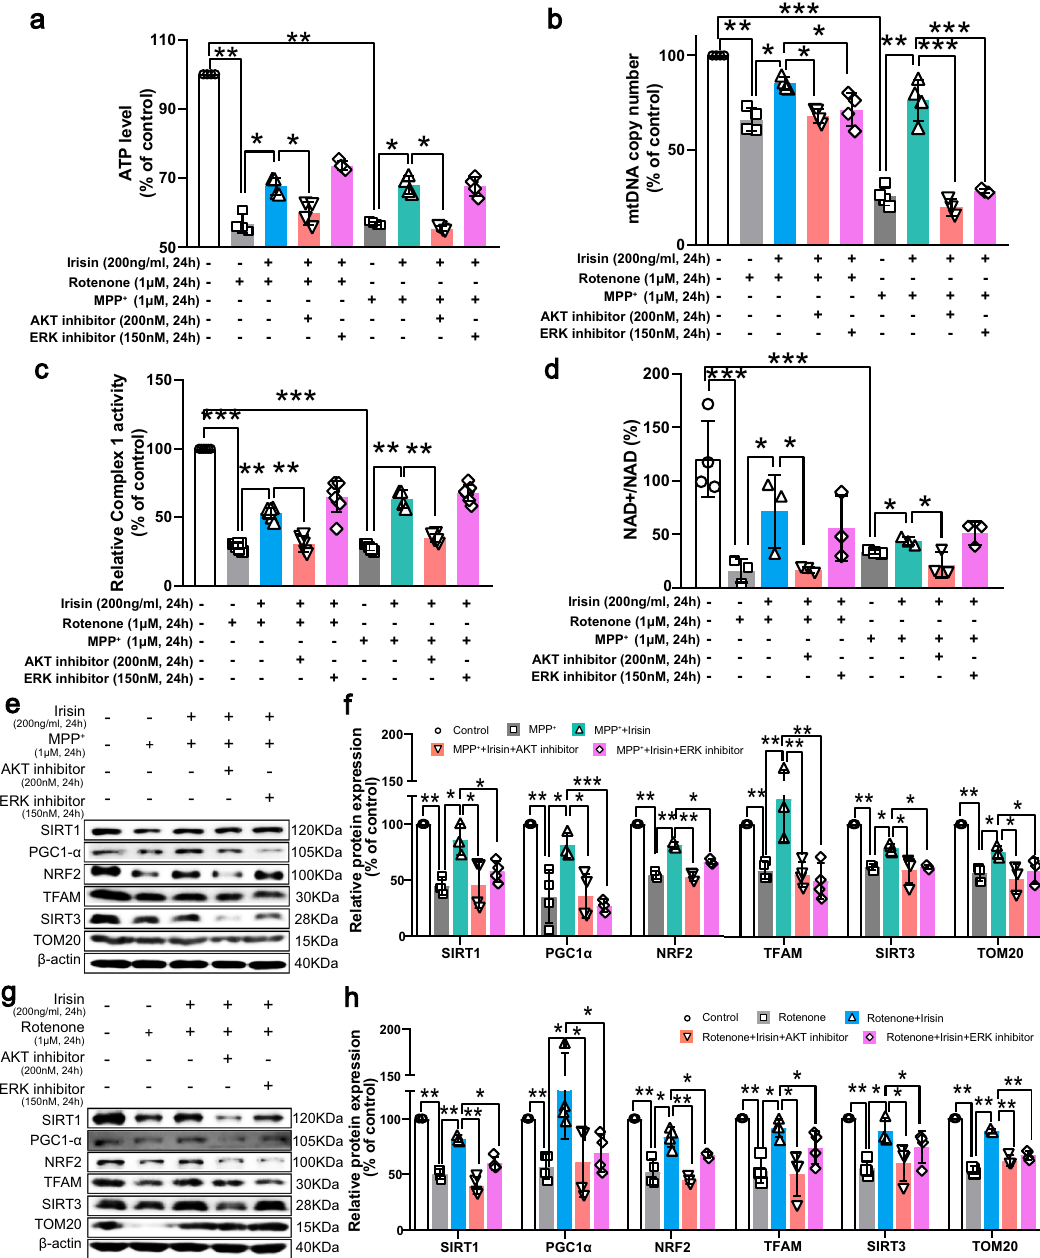
Fig. 9 Irisin renews mitochondrial function via activation of Akt and ERK1/2 signaling pathways in PD models induced by neurotoxins. a The ATP level in various groups of in vitro experiments. b mtDNA copy number in various groups of in vitro experiments. c Mitochondrial complex I activity in various groups of in vitro experiments. d NAD + /NADH ratio in various groups of in vitro experiments. e , f Western blot showing the quanti fi cation of SIRT1, PGC-1 α , NRF-2, SIRT3, TFAM and TOM20 in each group of SH-SY5Y cells treated by irisin, MPP + , Akt inhibitor and ERK1/2 inhibitor. g , h Western blot showing the quanti fi cation of SIRT1, PGC-1 α , NRF-2, SIRT3, TFAM and TOM20 in each group of SH-SY5Y cells treated by irisin, rotenone, Akt inhibitor and ERK1/2 inhibitor. All data are presented as mean ± SEM ( n ≥ 3). ∗ p < 0.05, ∗∗ p < 0.01, and ∗∗∗ p <